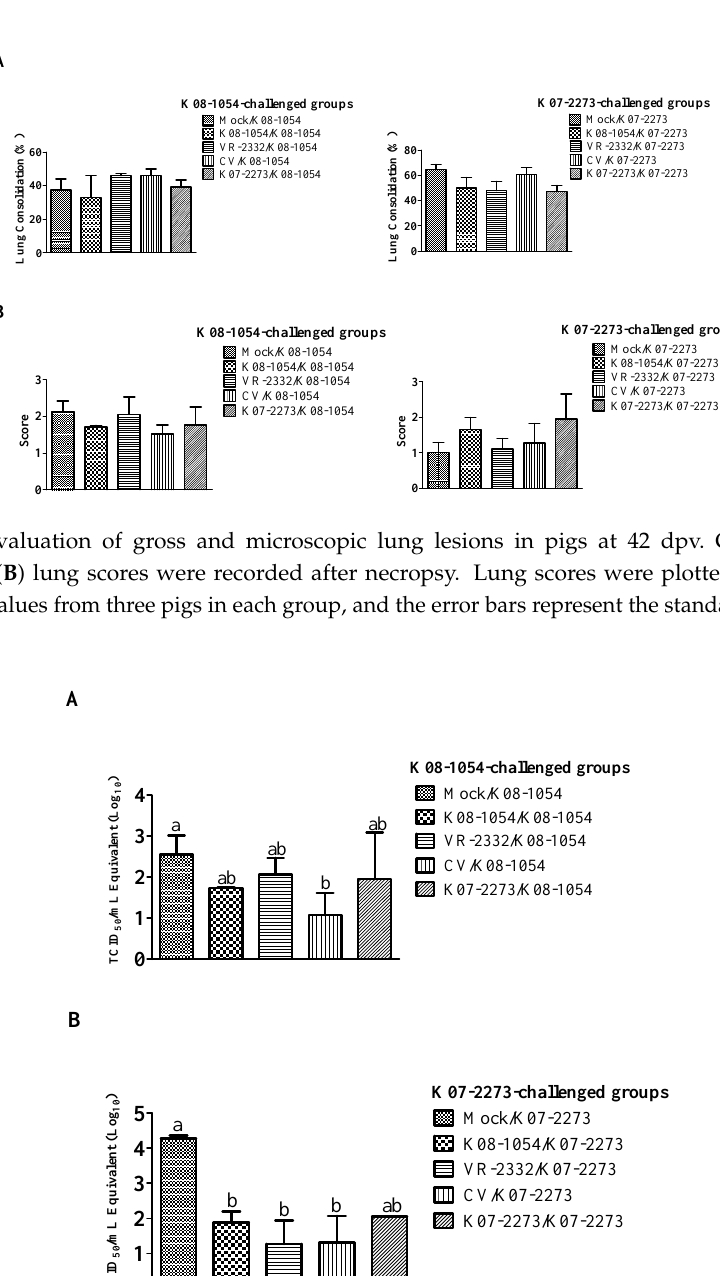
previous studies. A recent study has demonstrated that chimeric PRRS viruses harboring mixed